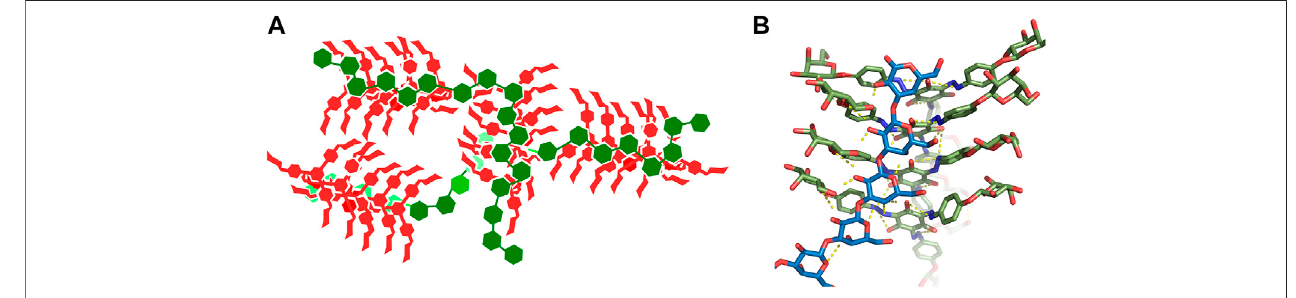
FIGURE 7 | (A) -Schematic view of a model of a complex of Yariv reagent with ß -(1 → 3)-galactans. Yariv is in red, saccharides are in green. (B) -Detailed view of the Y4H complex in replica